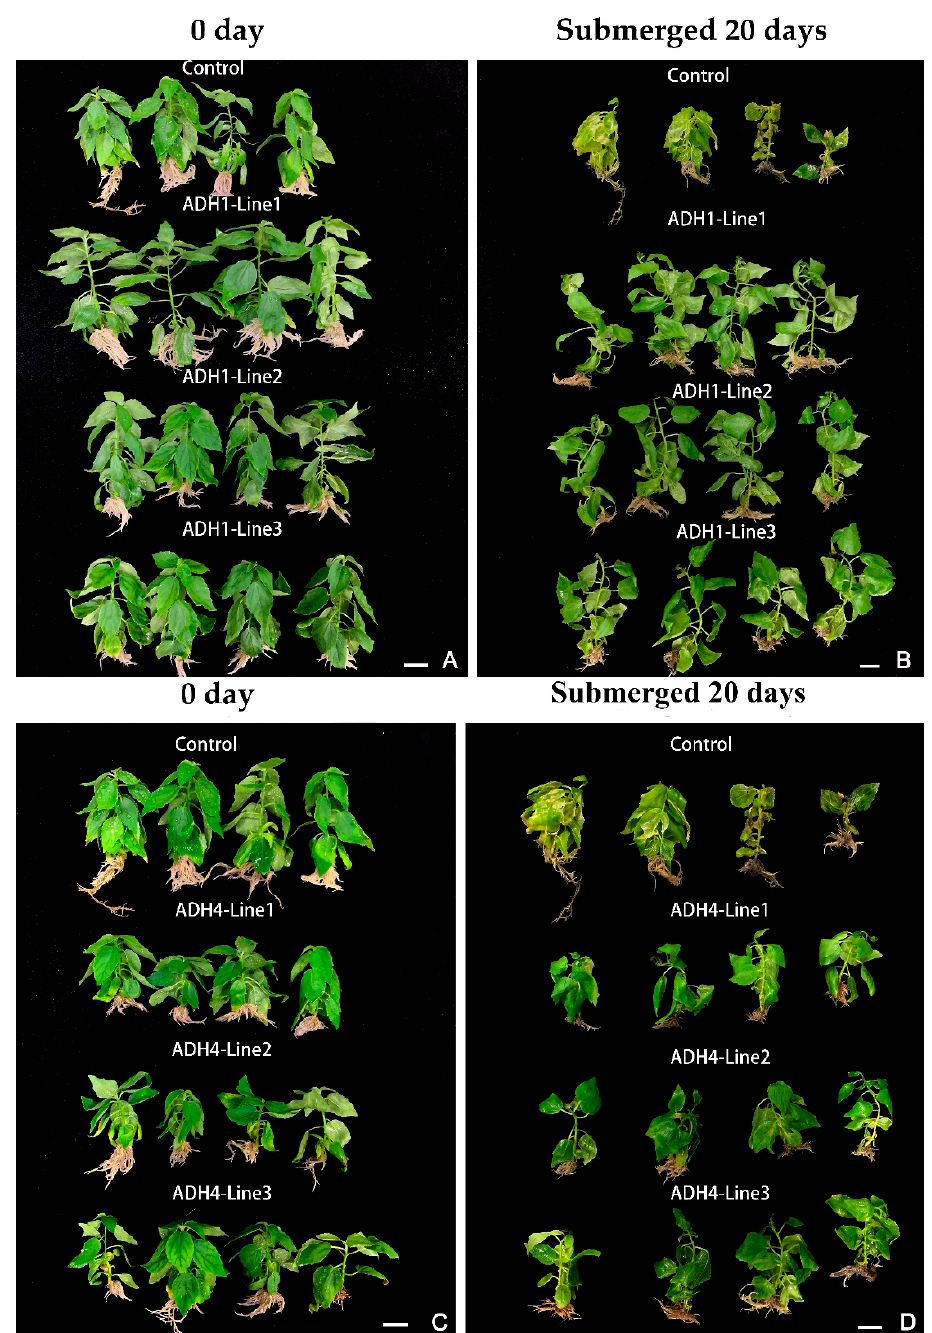
Figure 5. Overexpression of ThADH1 or ThADH4 conferred enhanced waterlogging tolerance in plants. ( A , C ) Phenotypic changes of transgenic Populus after 30 days of growth ADH1/ADH4 Lines 1–3 and non-transgenic (Control), respectively. ( B , D ) 30 days WT and transgenic Populus were photographed at the conclusion of submersion in deionized water for an additional 20 days. Bar scale=1.0 cm.